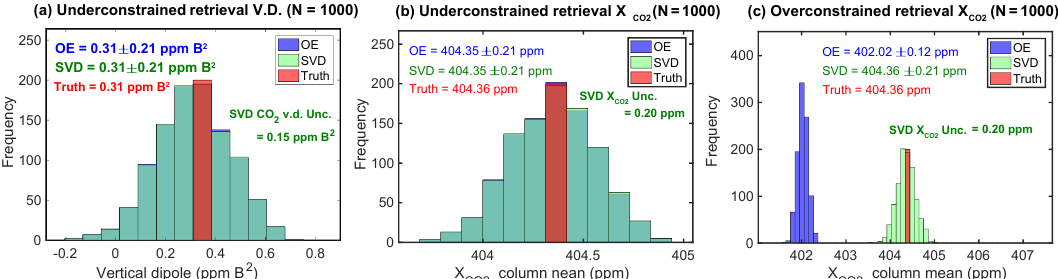
Figure 8. Ensemble results for retrieved CO 2 parameters from numerical simulations. For a weak constraint (see Fig. 6), the SVD method and OE methods both produce good results in the z basis for both the CO 2 vertical dipole moment (a) and X CO constitute the first two principal components (note that SVD and OE histograms are almost perfectly overlapped). Results are in line with the expected variance, S z from the SVD method. Under a strong constraint ( c , Fig. 7), the OE method produces a smaller standard deviation but starts to incur a bias, whereas the SVD method continues to produce accurate results but with no reduction in the variance. Note that for the strong constraint case, the SVD CO 2 vertical dipole moment is not